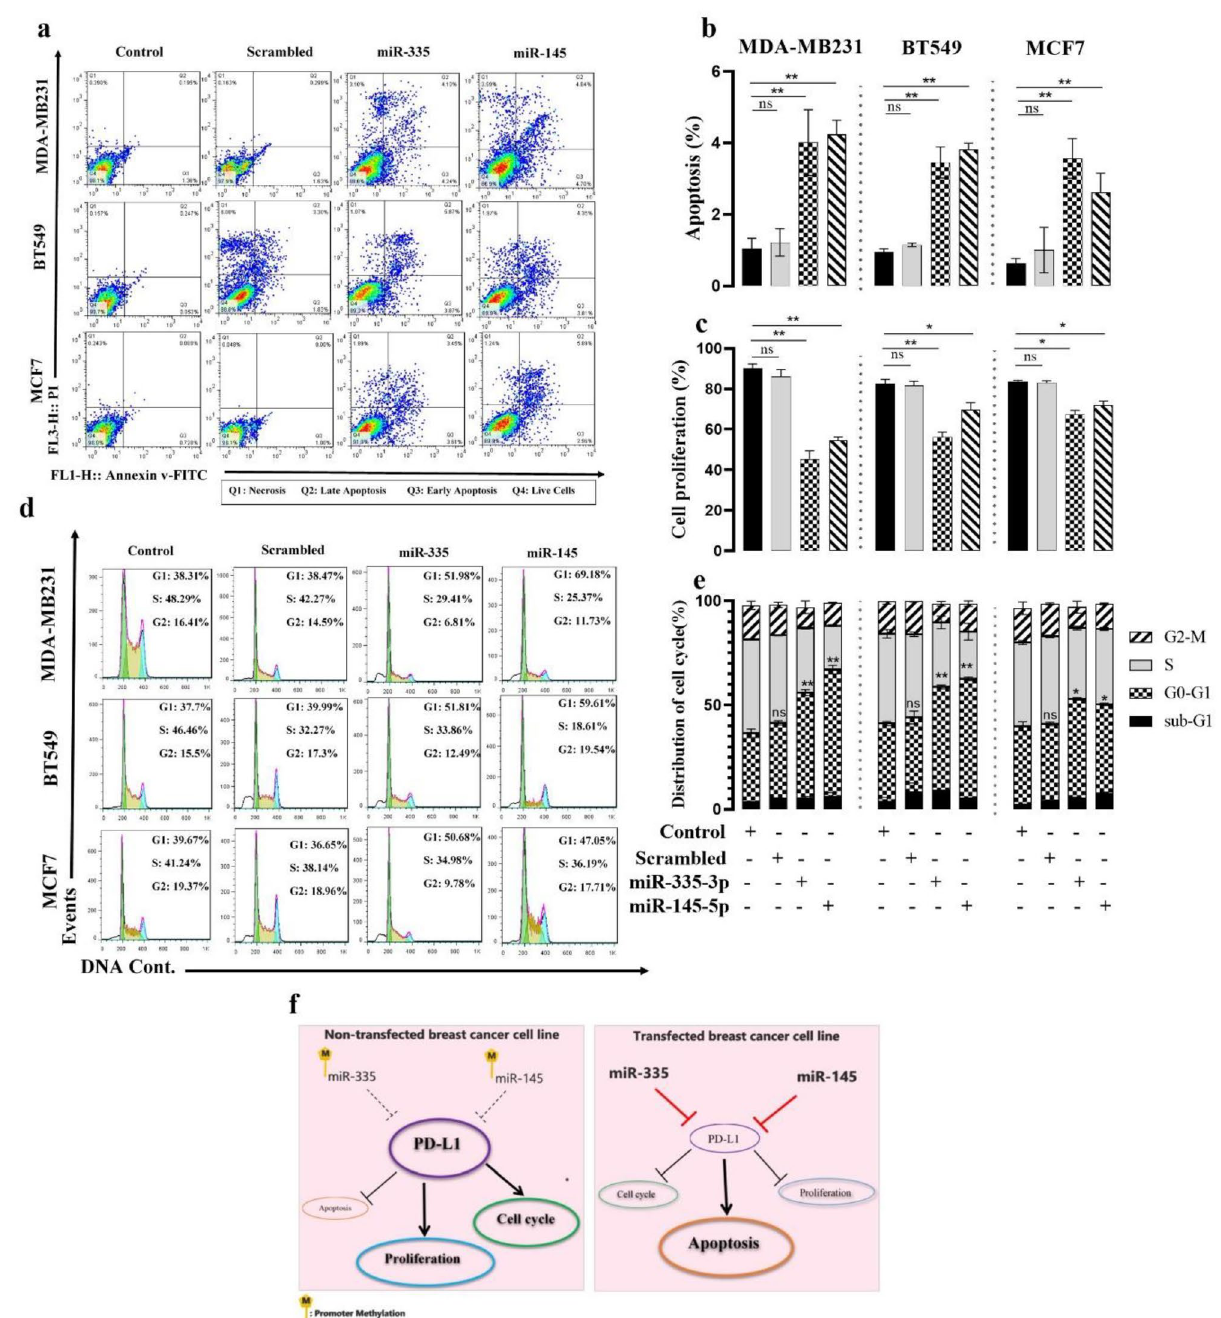
Figure 6. MiR ‐ 335 and -145 effects on BC cell apoptosis, proliferation, and cell cycle. ( a ) Apoptosis induction was investigated using flow cytometry. ( b ) Apoptosis rates are shown in the graphs; miR-335 and -145 transfection significantly increased apoptosis in MDA-MB231, BT549, and MCF7 cells. ( c ) A statistically significant reduction in MDA-MB231, BT549, and MCF7 cell proliferation was observed in the miR-335 and -145 groups when compared to the control groups. No difference was found between the control group and the scrambled group. ( d ) Analysis of the cell cycle distribution of PD-L1 expression due to overexpression of miR-335 and-145 could arrest the cell cycle at the G0/G1 phase. ( e ) The graphs show the percentage of cells in each cell cycle phase. ( f ) Schematic graph depicting the function of miR-335 and -145 in breast cancer. MiR-335 and -145 overexpression leads to PD-L1 inhibition, which leads to enhanced proliferation and the cell cycle while inhibiting apoptosis in breast cancer. Overexpression of miR-335 and -145 reinforces the suppression of its target PD-L1, leading to the suppression of tumorigenicity in breast cancer. *P ≤ 0.05, **P ≤ 0.01, ns = non-